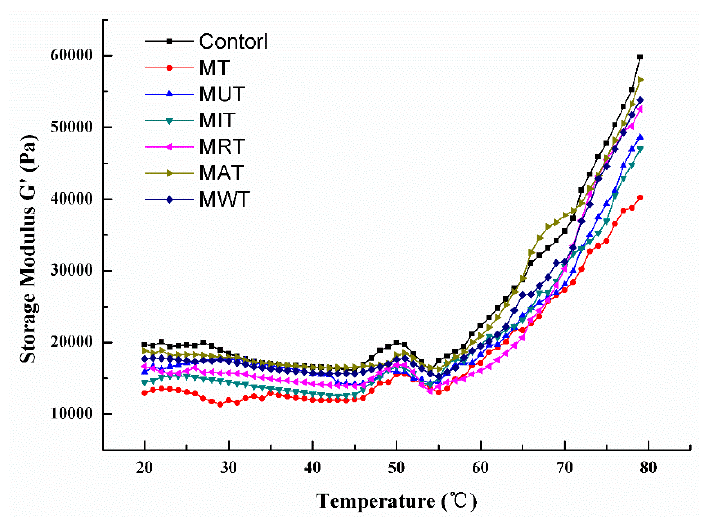
Figure 6. Changes in dynamic storage modulus ( G’ Pa) of pork samples under six di ff erent thawing conditions. MT: Microwave thawing (100 W); MUT: Microwave combined with ultrasonic thawing; MIT: Microwave combined with 35 ◦ C water immersion thawing; MRT: Microwave combined with 4 ◦ C refrigeration thawing; MAT: Microwave combined with air convection thawing; MWT: Microwave combined with running water thawing. Table 3. Denaturation temperature T m ( ◦ C) and enthalpy (cid:52) H (J g − 1 ) for the muscle proteins in pork samples under six di ff erent thawing conditions (analyzed by di ff erential scanning calorimetry (DSC)). Peak 1 Thawing Ways